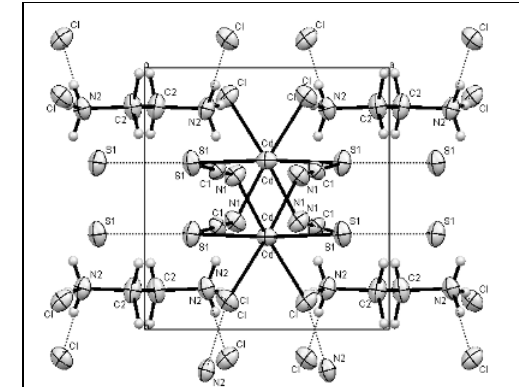
Fig.3. Projection along the c-axis of C 2 H 10 N 2 CdCl 2 (SCN) 2